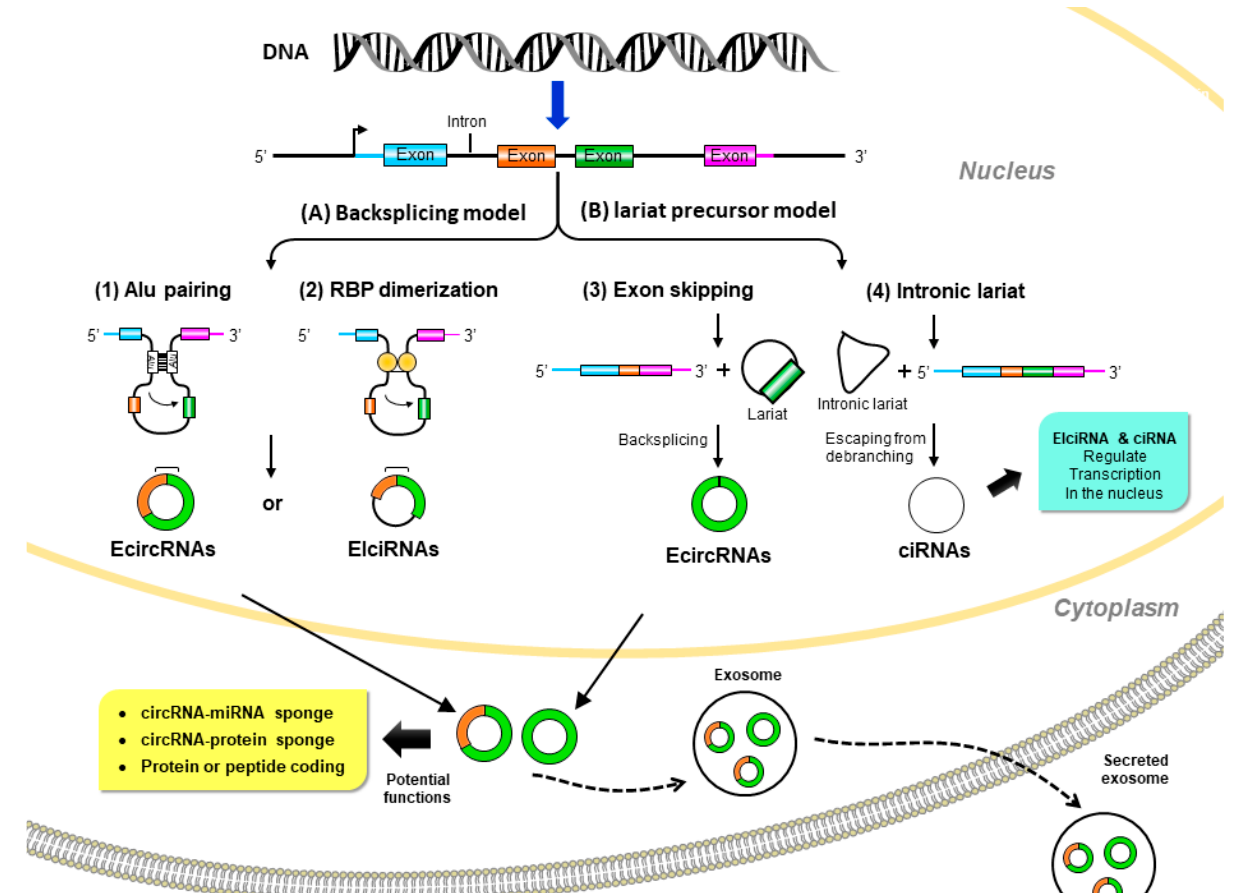
Figure 1. Biogenesis and potential biological functions of circular (circ)RNAs. ( A ) Back-splicing model: pre-mRNA is spliced in a non-canonical manner of “back-splicing” by ( 1 ) inverted repeat elements in long flanking intron pairs, such as Alu elements, or ( 2 ) dimerization of RNA-binding proteins (RBPs). During back-splicing, an upstream branch point attacks a downstream splice donor site to form exonic circRNAs or exon–intron circRNAs. ( B ) Lariat precursor model: pre-mRNA undergoes canonical splicing to generate a linear mRNA and a lariat precursor. ( 3 ) The lariat precursors with exon components might be generated from exon-skipping events and then further back-spliced to exonic circRNAs. Alternatively, ( 4 ) the intronic lariat precursors escape from the debranching step of canonical linear splicing to form intronic circRNAs. Exonic circRNAs are transported from the nucleus to the cytoplasm to function as miRNA sponges to inhibit miRNA activity; protein sponges (such as RBPs) affect protein functions and translocation or protein-coding to further translation. Exon–intron circRNAs and intronic circRNAs can interact with transcription complexes to regulate transcription in the nucleus.